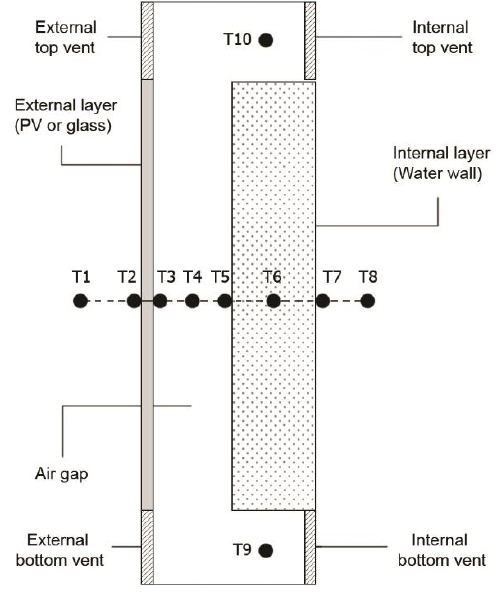
Figure 3. BIPV-WS prototype configuration [15].